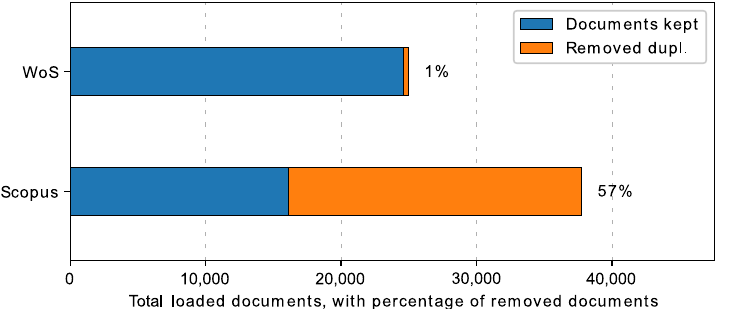
Figure 2. ScientoPy data preprocessing from datasets downloaded from Clarivate Web of Science and Scopus, showing unique papers in blue and removed duplicates in orange.